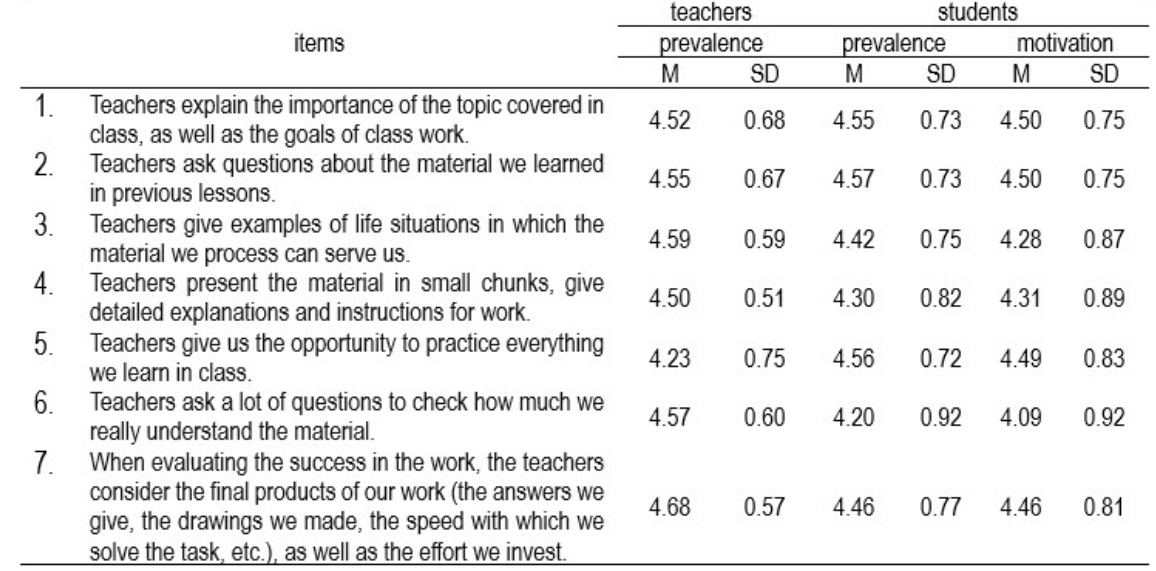
Descriptive statistics of evaluation of items in Effective teaching